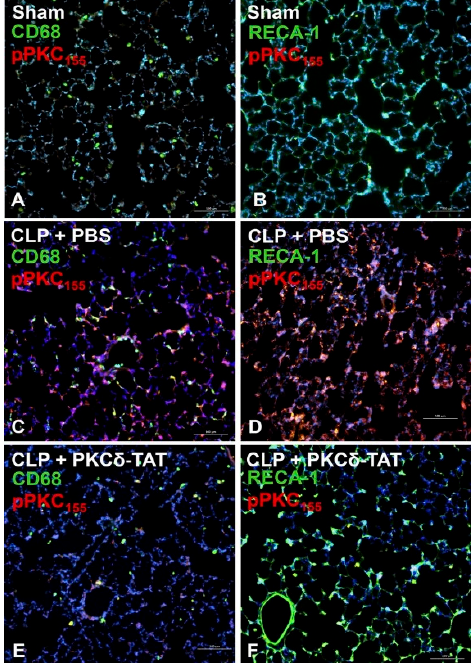
Figure 5. Immunohistochemical analysis of PKC δ phosphorylation at tyrosine 155 (pPKC δ 155 ; red) in lung tissue sections at 24 h post-surgery of sham-operated animals (Sham) ( A , B ) and CLP-operated animals that received 200 µ g/kg PKC δ -TAT (CLP + PKC δ -TAT) ( E , F ) or a similar volume of PBS vehicle only (CLP + PBS) ( C , D ) immediately following surgery. ( A , C , E ) Tissue sections were also stained for CD68 (green), a marker for the cells of the macrophage lineage. Yellow/orange indicates co-localization of pPKC δ 155 and CD68. ( B , D , F ) Tissue sections were also stained for rat endothelial cell antigen-1 (RECA-1; green), a marker for rat endothelial cells. Yellow/orange indicates co-localization of pPKC δ 155 and RECA-1. All scale bars = 100 microns. Reprinted with permission from Mondrinos et al., 2015 [24].